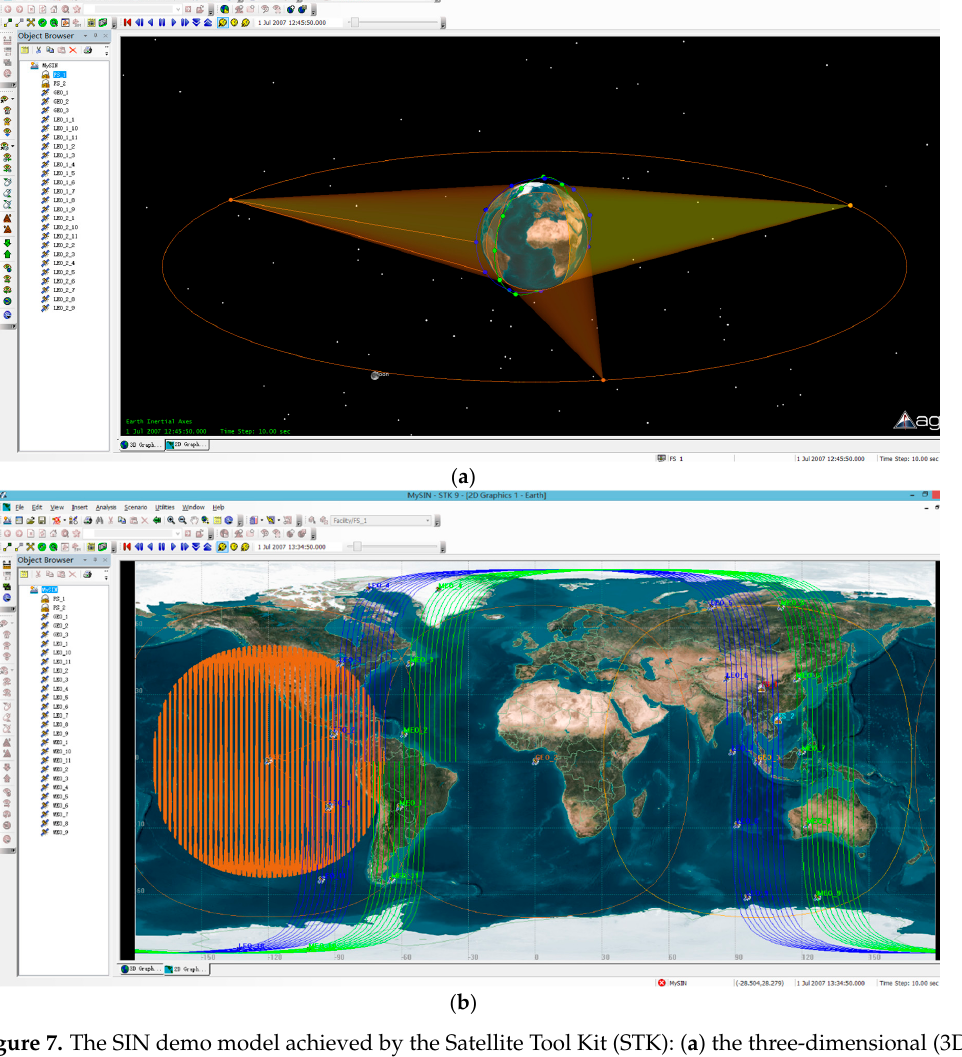
Figure 7. The SIN demo model achieved by the Satellite Tool Kit (STK): ( a ) the three-dimensional (3D) demo model; and ( b ) the two-dimensional (2D) demo model.